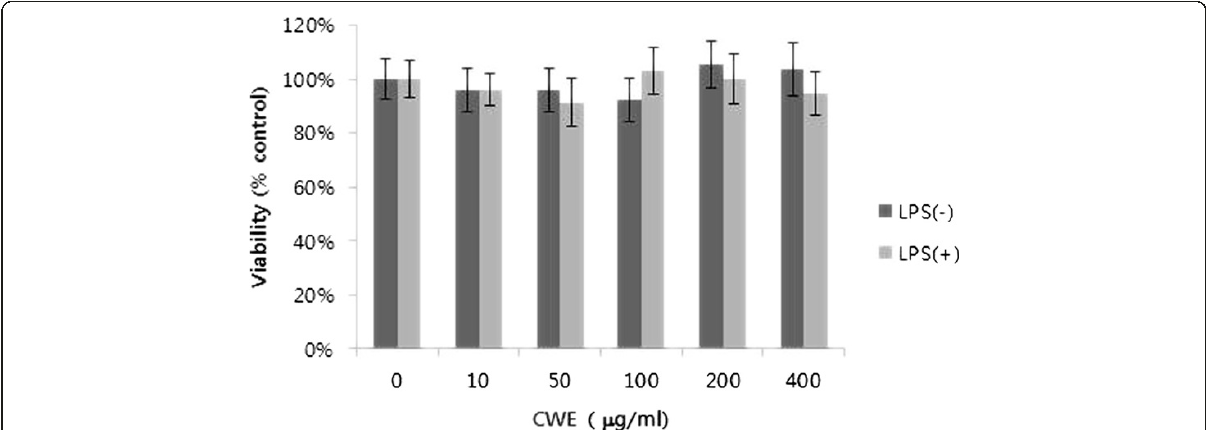
Figure 2 In vitro effect of CWE on the viability of macrophages. Peritoneal macrophages from thioglycollate-injected mice were isolated and treated with varying concentrations of CWE for 24 hours with or without LPS (100 ng/ml). Cell viability was measured by the MTT assay. Control: